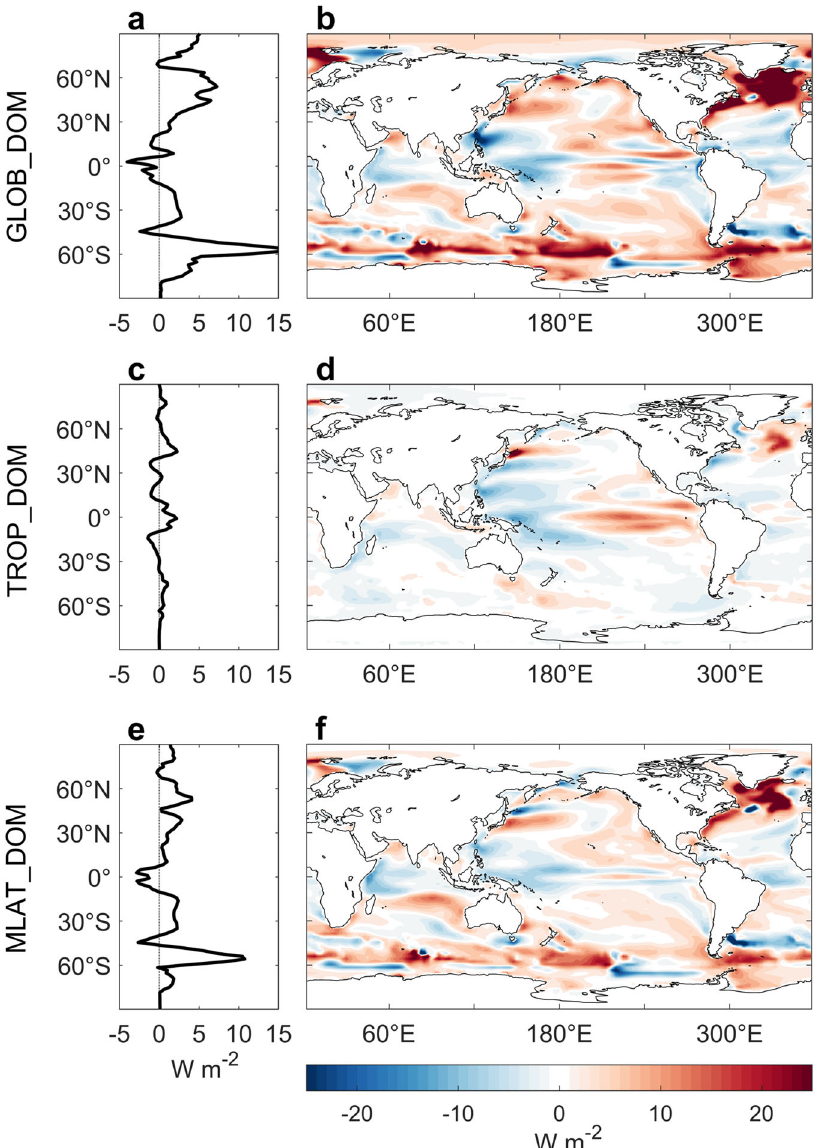
Fig. 5 Ocean heat uptake responses to CO 2 forcings. The annual- and zonal-mean ocean heat uptake responses (i.e., downward positive net surface heat fl ux) for a GLOB_DOM, c TROP_DOM, and e MLAT_DOM. b , d , f The spatial changes in ocean heat uptake corresponding to a , c , e